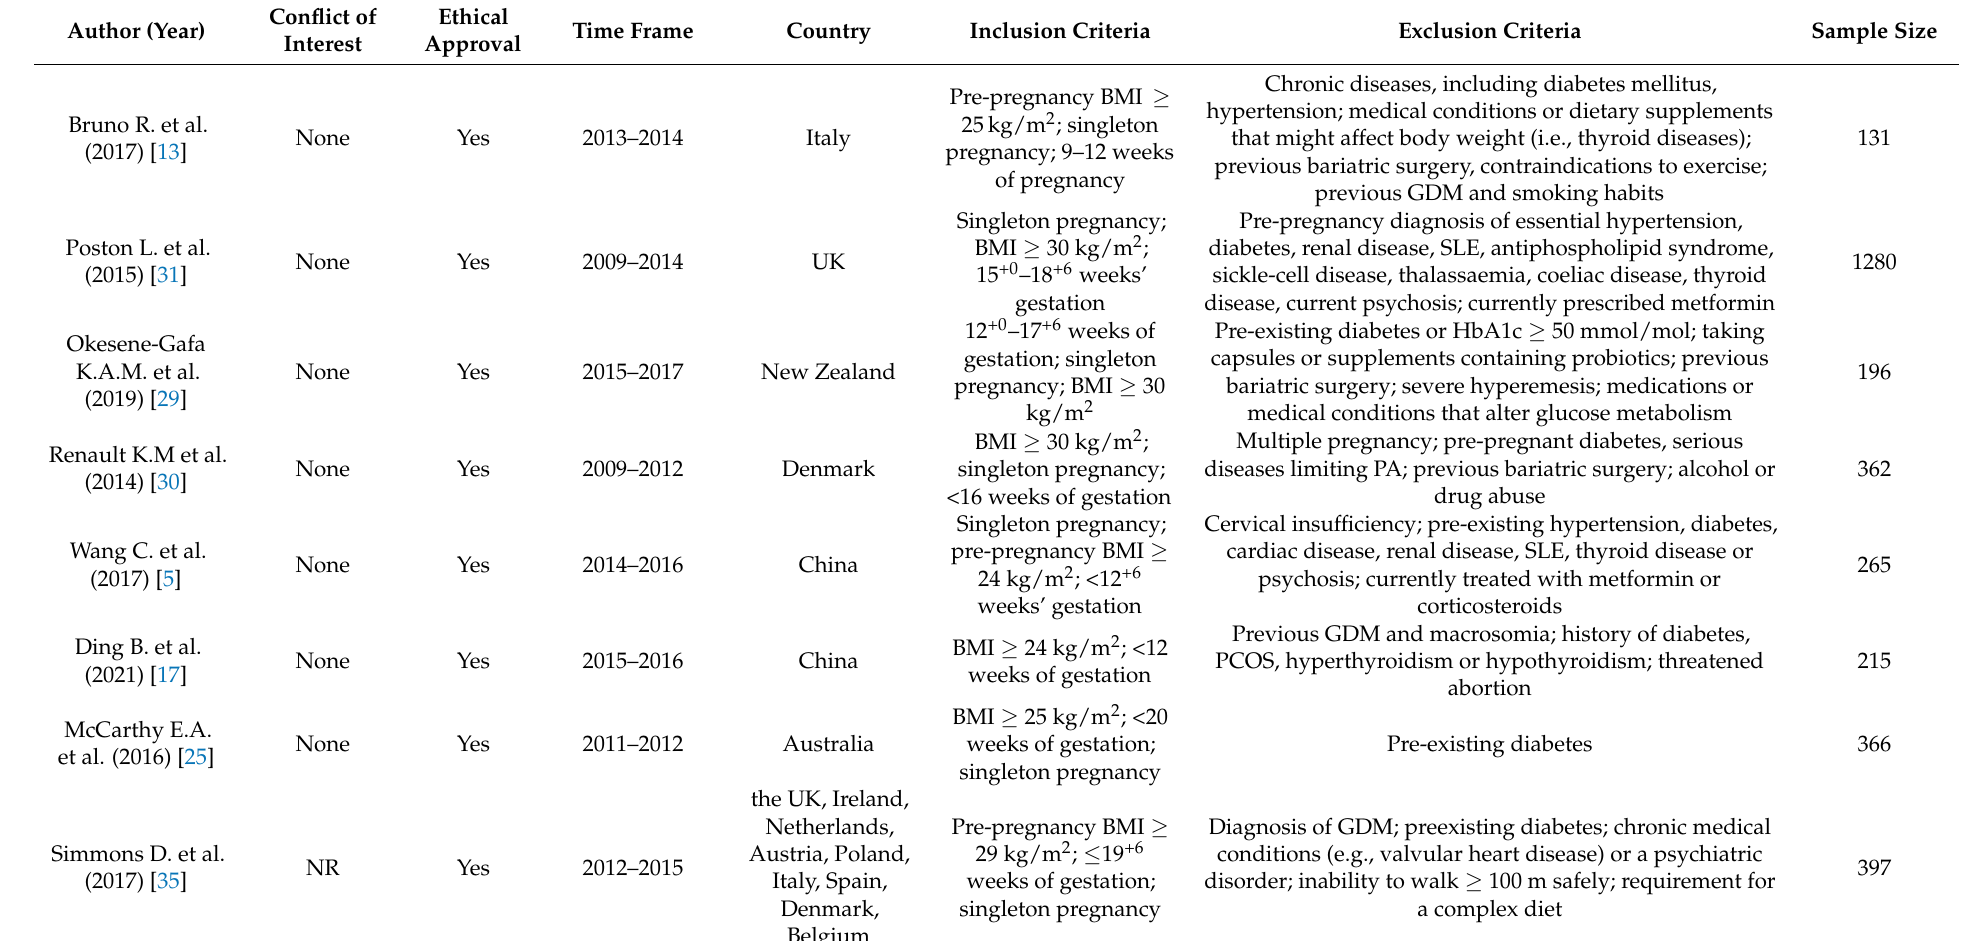
Table 1. Characteristics of included